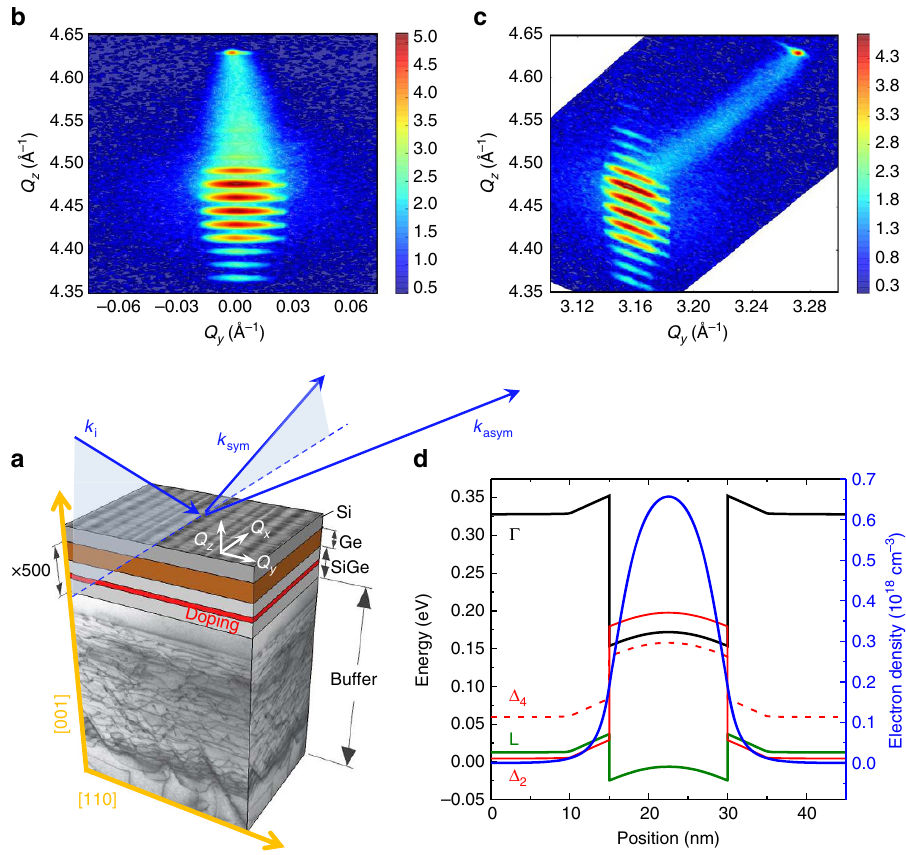
Figure 1 | Sample structure and band-edge alignment. ( a ) Sketch of the structure (not to scale) of the n-type (P atoms) modulation doped Ge/SiGe QWs samples. Each sample consists of a 500-fold-stack of QWs grown on (001)Si substrates. A sketch of the incident, k i , and diffraction wave vectors, k sym and k asym , corresponding respectively to the (004) and (224) reciprocal lattice points, is shown. Q i refers to the measured scattering vector, here i ¼ x , y , z . ( b , c ) Symmetric (004) and asymmetric (224) XRD reciprocal space maps of the sample with 20nm QWs, respectively. The colour scale bar represents the XRD logarithmic intensity as counts-per-second. ( d ) Calculated conduction band alignment and electron density in the Ge/SiGe multiple QW